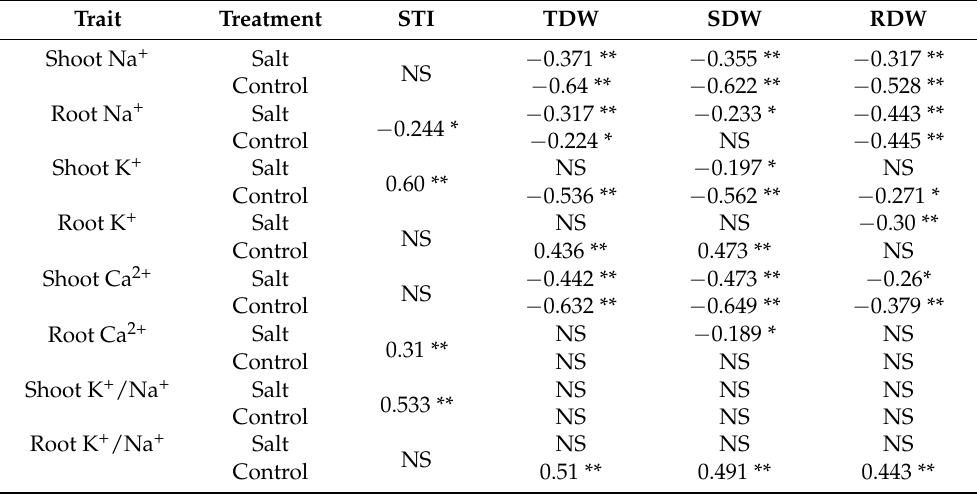
Figure 2. Correlation matrix of 24 morpho-physiological traits along with salt tolerance index (STI) evaluated at 150 mM NaCl (* and ** represent significance at p ≤ 0.05, p ≤ 0.01 respectively). Table 2. Coefficients of correlation (r) between ionic traits of the shoot and root plant and salt tolerance index (STI), total dry weight (TDW), shoot dry weight (SDW), and root dry weight (RDW) after 15 days of 150 mM NaCl salt stress